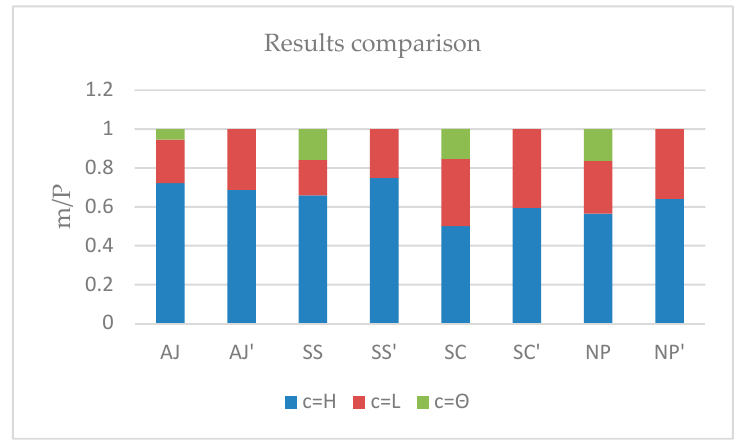
Figure 5. A comparison of the results obtained through the two methods (Bayesian and evidential).